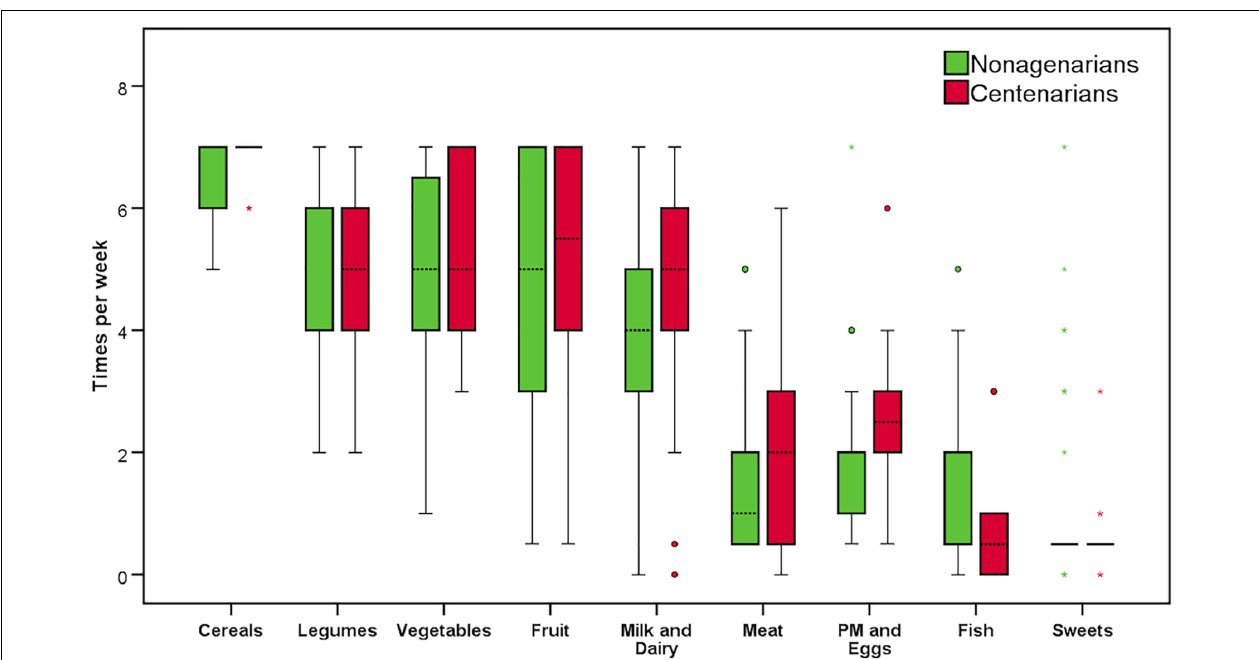
FIGURE 2 | Frequency of consumption of food groups in the nonagenarian and centenarian populations. PM, processed meat. Circles and asterisks represents outlier and extreme outlier values,